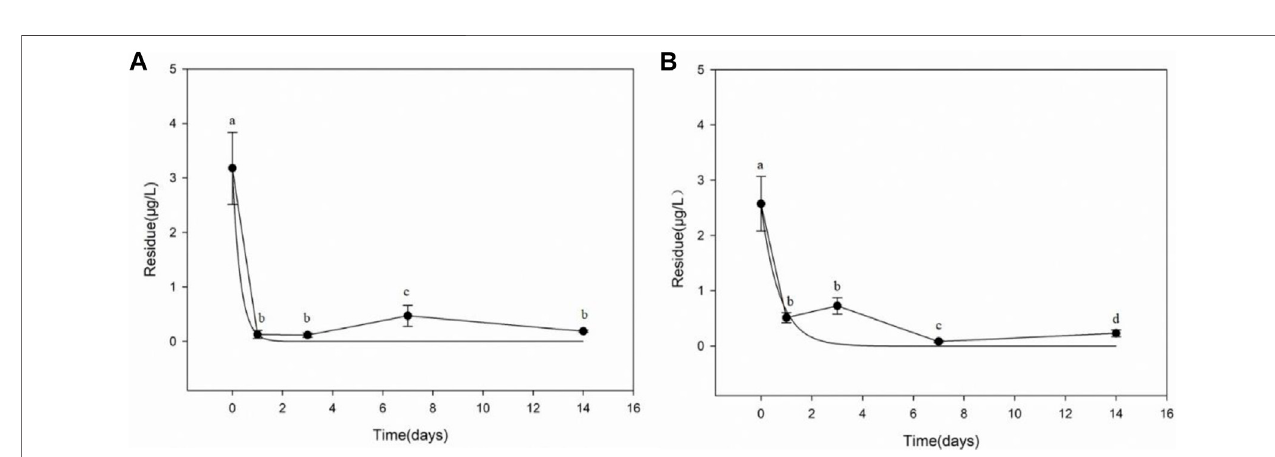
FIGURE3| Dissipationofdifenoconazoleinpaddywater. (A) Chemicalfertilizertreatmentplot. (B) Biogasresiduetreatmentplot.ErrorbarisS.D.( N = 3).Different lowercase letters denote signi fi cant differences ( p < 0.05), analyzed by ANOVA followed by Duncan multiple comparison test.